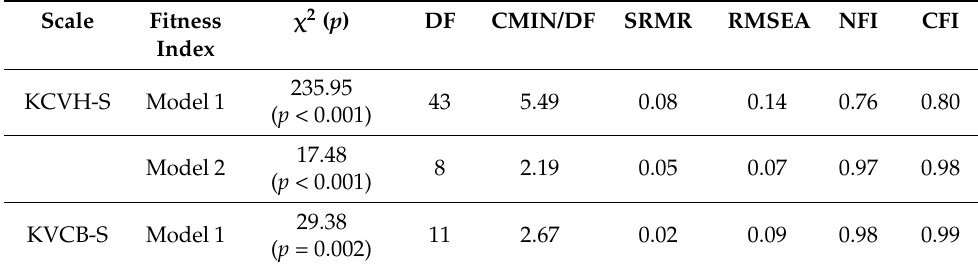
Table 3. Analysis of construction validity.